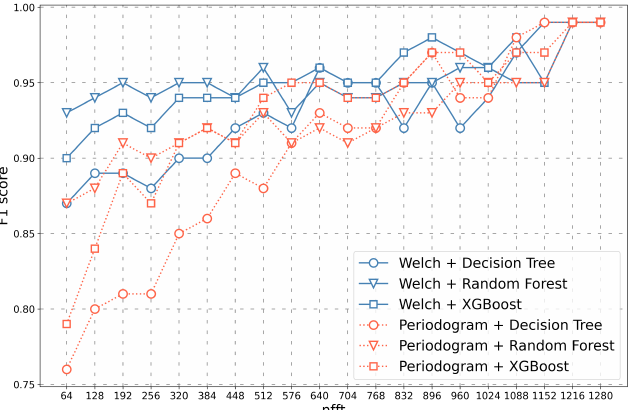
Figure 5. The value of the F1 score parameter depending on the nf ft value for various transformation methods and classifiers-results obtained for three connected channels (R + G +